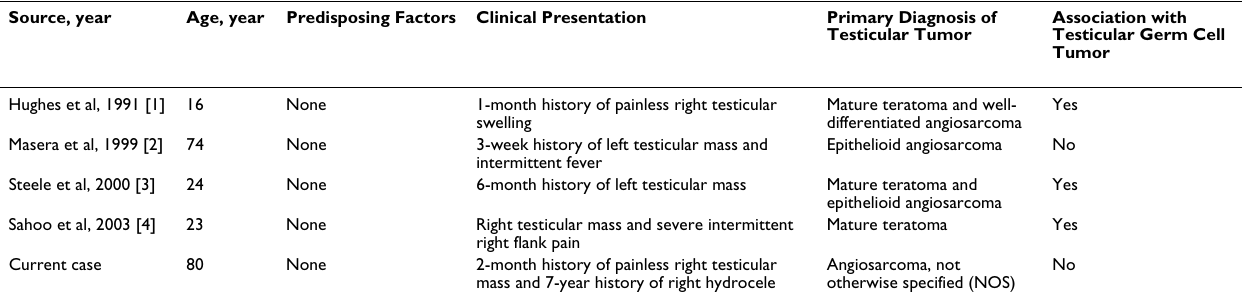
Table 1: Clinical characteristics of primary testicular angiosarcoma Source,